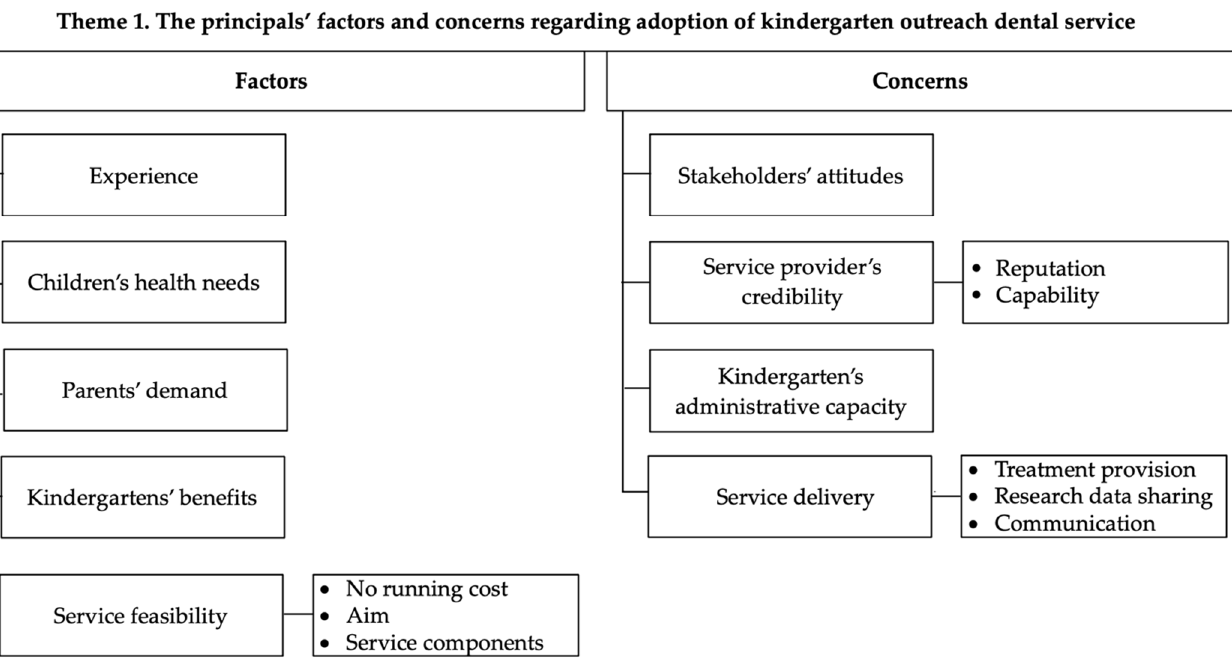
Figure 1. The principals’ factors and concerns regarding adoption of the kindergarten outreach den- tal service. dental